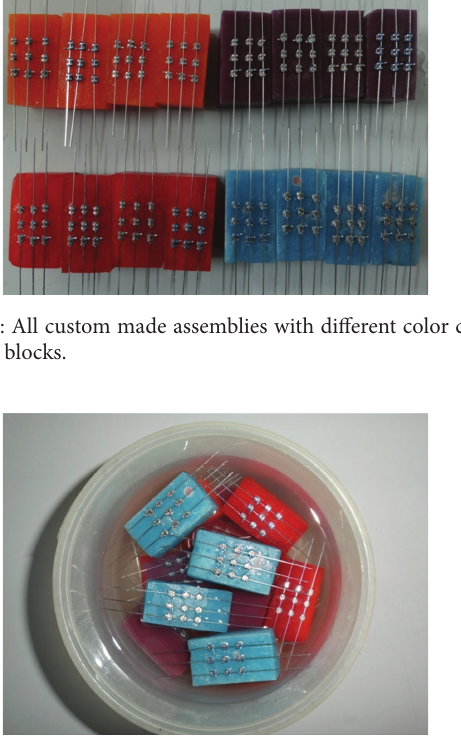
Figure 3: Custom made assemblies immersed in artificial